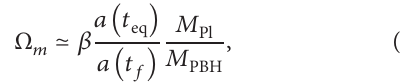
for value of PBH